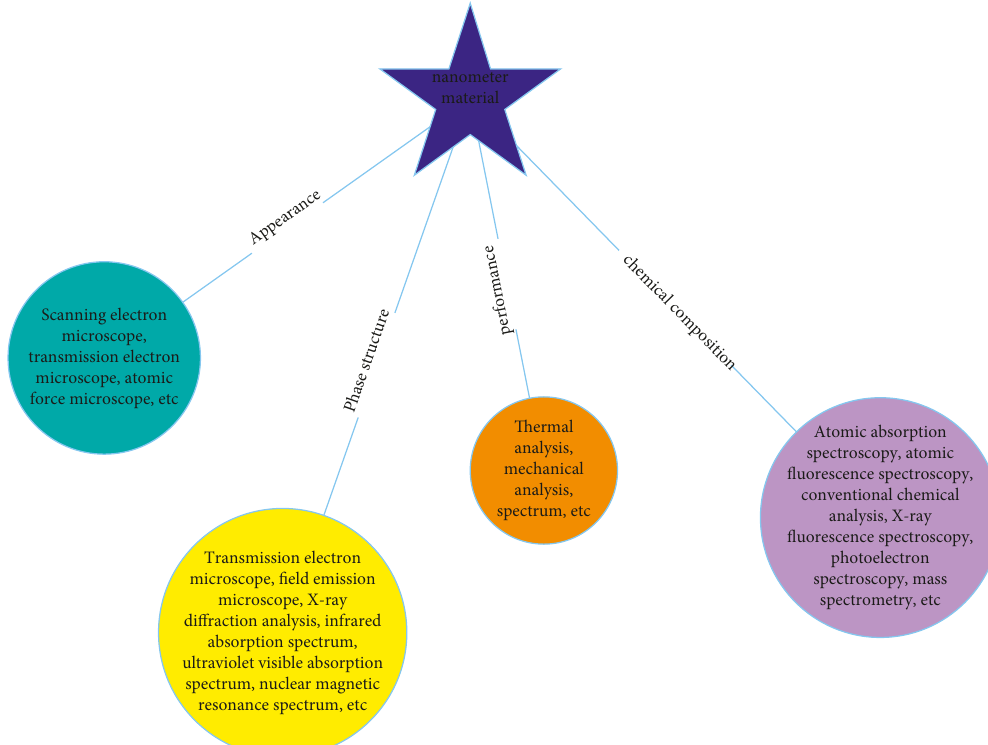
Figure 3: Nanomaterials characterization